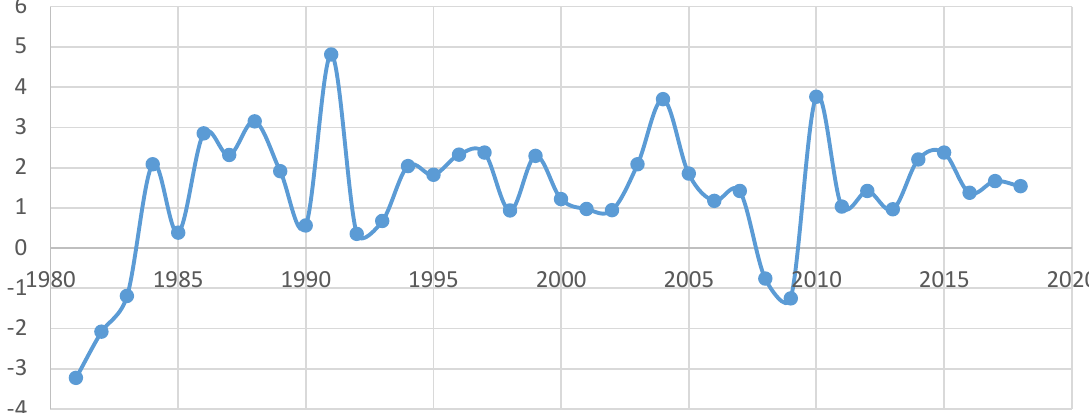
Figure 1. Change of average daily demand for crude oil worldwide from (Statista) 1980 to 2018